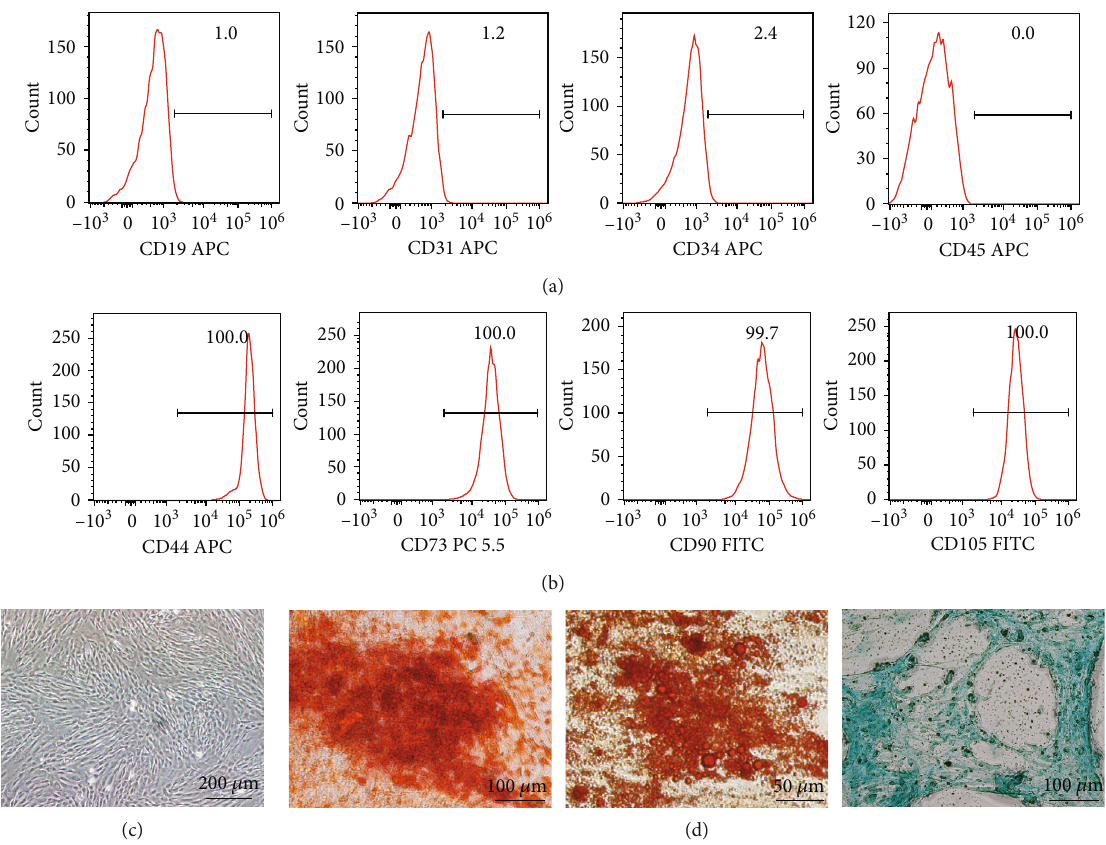
Figure 1: The characterization of UC-MSCs. (a, b) The identi fi cation of negative surface makers CD19, CD31, CD34, and CD45 and positive makers CD44, CD73, CD90, and CD105 of UC-MSCs from passage 5 using fl ow cytometry. (c) Morphological image under an inverted microscope. Scar bar = 200 μ m. (d) Osteoblastic ability was validated by Alizarin Red staining 21 d after di ff erentiation. Scar bar = 100 μ m; adipogenesis was assessed with Oil Red O staining 14 d after inducing. Scar bar = 50 μ m; chondrogenic di ff erentiation was stained with Alcian Blue dye. Scar bar = 100 μ